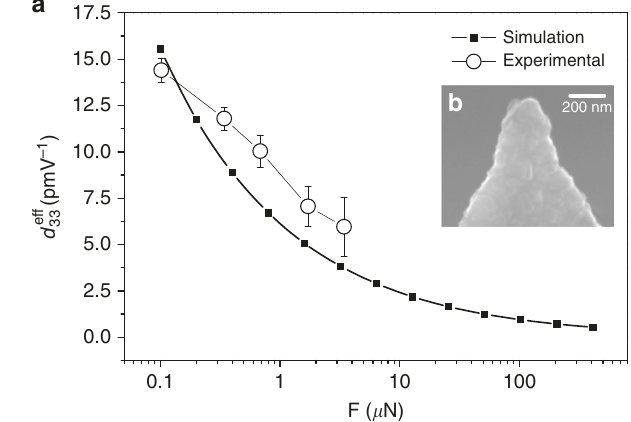
Fig. 4 Study of converse fl exoelectricity induced at the tip apex of an atomic force microscope cantilever as a function of the applied force. a Effective piezoelectric coef fi cient as a function of applied force for the SrTiO3 crystal. Filled squares correspond to the values obtained after the simulation. Empty circles correspond to the experimental values obtained with a Nanosensors CDT FM tip with a cantilever of medium stiffness ( k ≈ 2.8Nm − 1 ) coated with doped diamond. The error bars correspond to the error of the linear fi tting of the experimental data, which correlates the measured electromechanical amplitude of oscillation Δ h with the V ac applied voltage. b The effective contact radius a scales with the force, and is determined